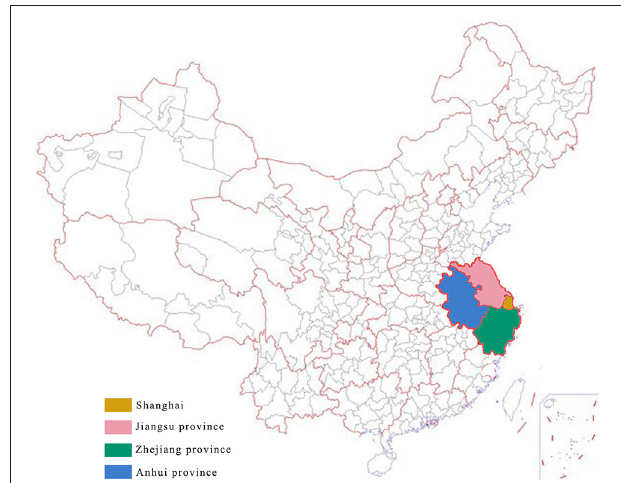
FIGURE 1 | The location of Yangtze River Delta in China and the relative locations of the studied regions (i.e., Shanghai city, Jiangsu province, Zhejiang province, and Anhui